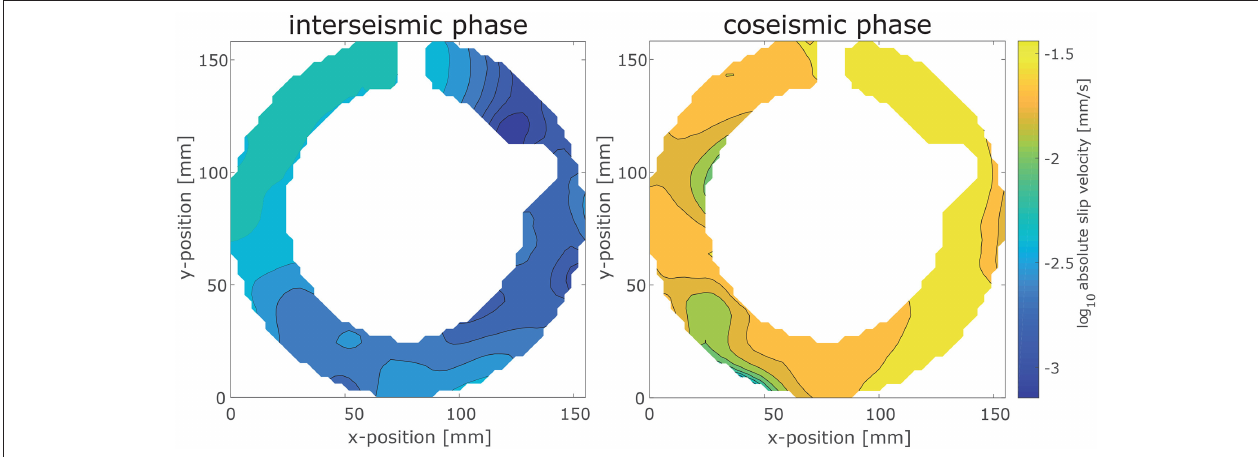
FIGURE 1 | Comparison of the slip velocity in the experimental setup during the interseismic (Left) and coseismic (Right) phase. The slip velocity during an event is almost 2 orders of magnitude higher than during the interseismic phase. The colorbar is valid for both plots.